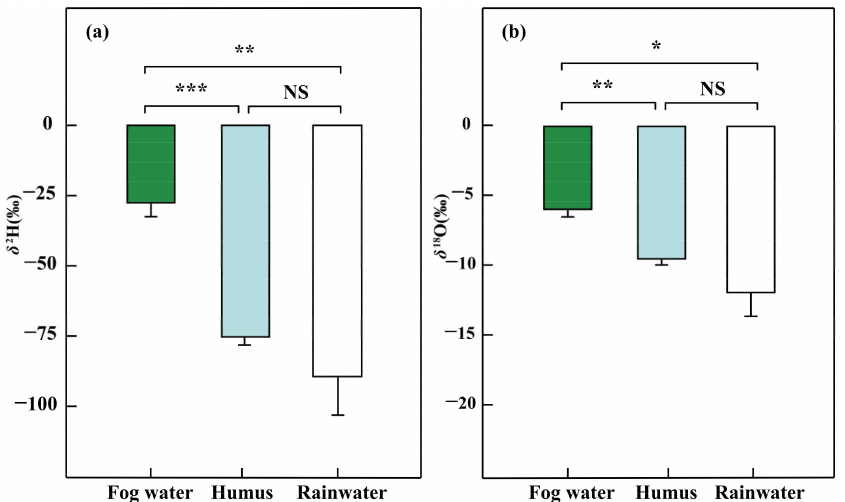
Figure 3. The δ 2 H ( a ) and δ 18 O (‰) ( b ) of different water sources (Fog water, n = 7; humus, n = 4; and rainwater, n = 5) in the dry season, January 2019. Wilcoxon rank sum test is used to verify the differences of water source samples (NS > 0.05, * p < 0.05, ** p < 0.01, *** p < 0.001); Error bars represent means ± SEs of different water